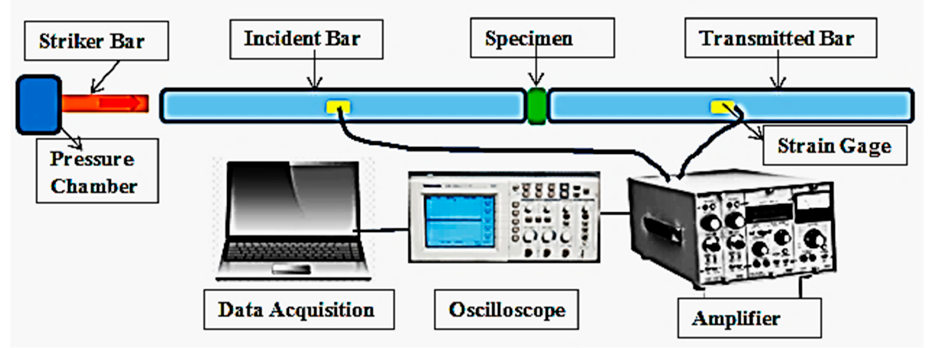
Figure 10. Split Hopkinson pressure bar (SHPB) setup.